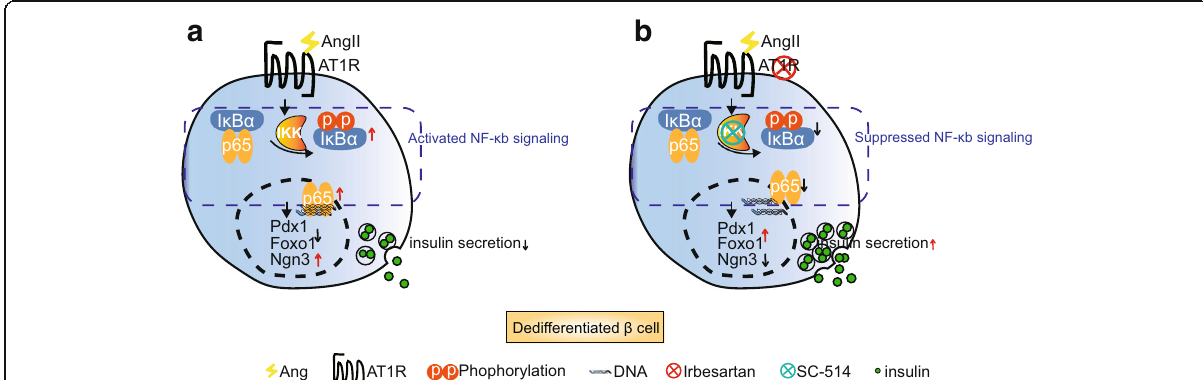
Fig. 6 (color; online only) (a) Metabolic stress (i.e., oxidative stress, proinflammatory cytokines) is a major contributor to β -cell dedifferentiation, and activation of RAS is involved in induction of metabolic stress. Angll contributes to β cell dedifferentiation via activating AT1R and the contribution is supported by the activation of NF- κ b signaling. This process results in compromised β cell identity and β cell dedifferentiation (PDX1 ↓ FOXO1 ↓ NGN3 ↑ ), thus decreasing insulin secretion. b When NF- κ b signaling is suppressed by sc-514 (IKK inhibitor), the dedifferentiation effect of Angll on β cells is alleviated (PDX1 ↑ FOXO1 ↑ NGN3 ↓ ), resulting in increased insulin secretion. A RAS inhibitor showed a similar effect on β